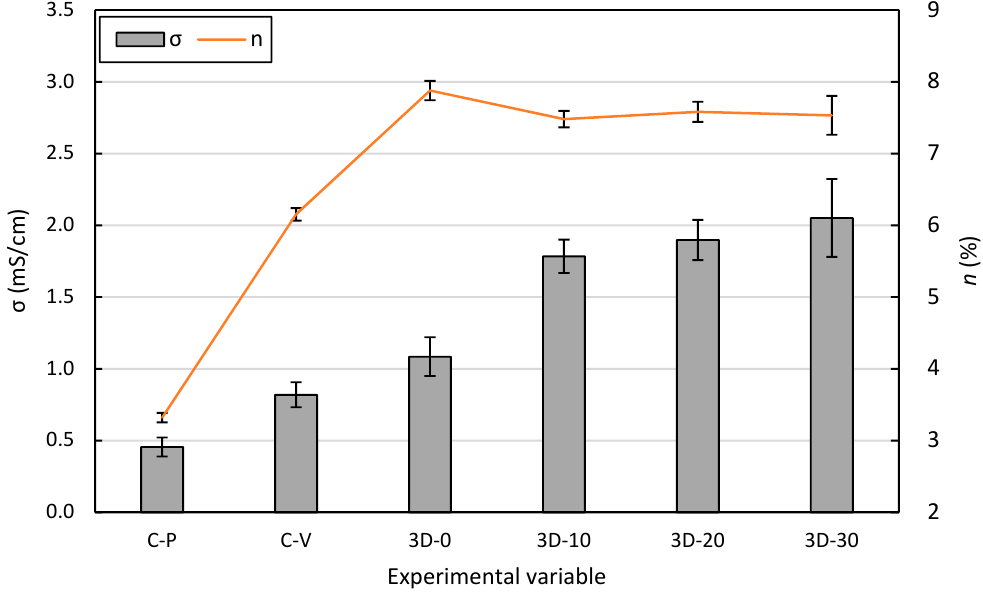
Figure 13. CCI results.